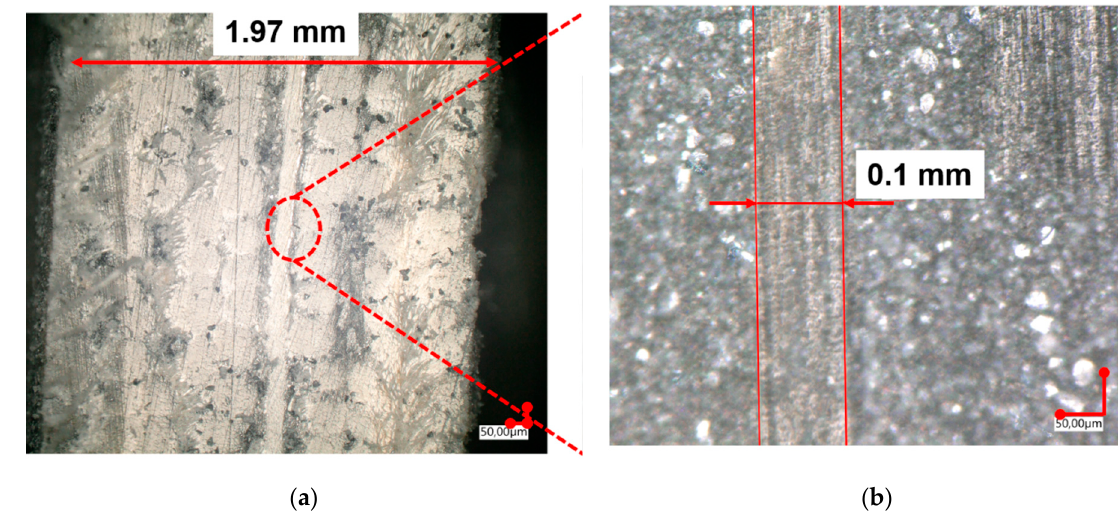
Figure 5. ( a ) Optical microscopy image showing the cross-section of the epoxy/natural fiber composite laminate with paper; ( b ) enlarged view of impregnated paper in the composite laminate.